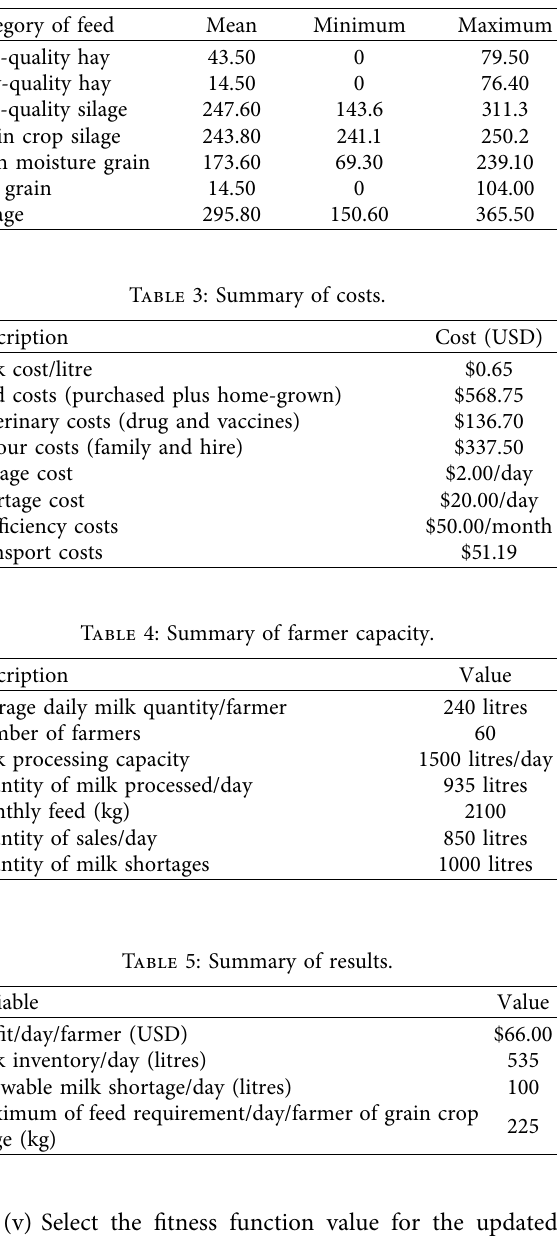
Table 2: Summary of feed available.